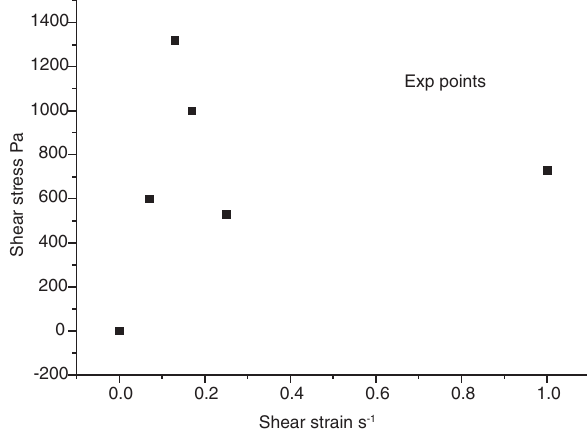
Figure 4: Experimental data of shear stress vs. shear strain (Hu